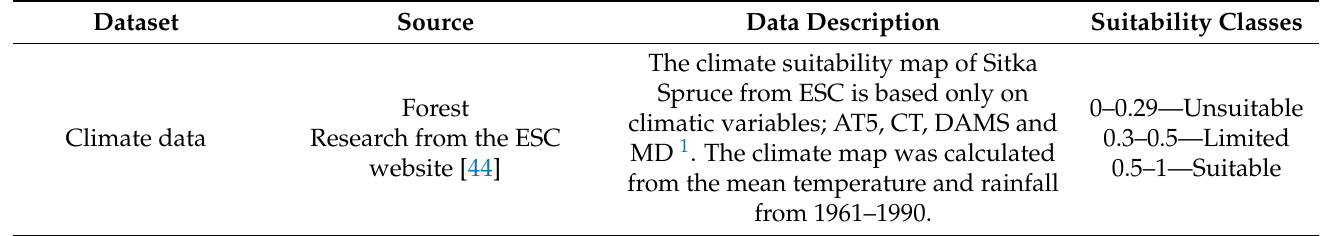
Table 1. Description of the climate data classification from ESC [44].